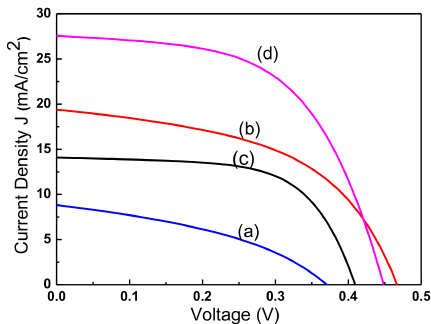
Figure 4. The surface SEM images of Cl-doped ZnO films that were electrodeposited using electrolytes with four pH values of ( a ) 7.1,( b ) 6.4, ( c ) 5.2, and ( d ) 4.2.